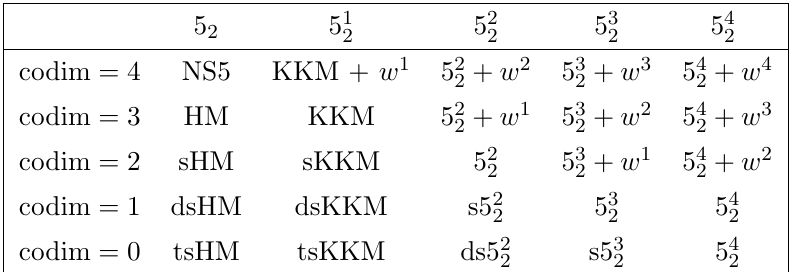
-brane, see [4, 5]. n